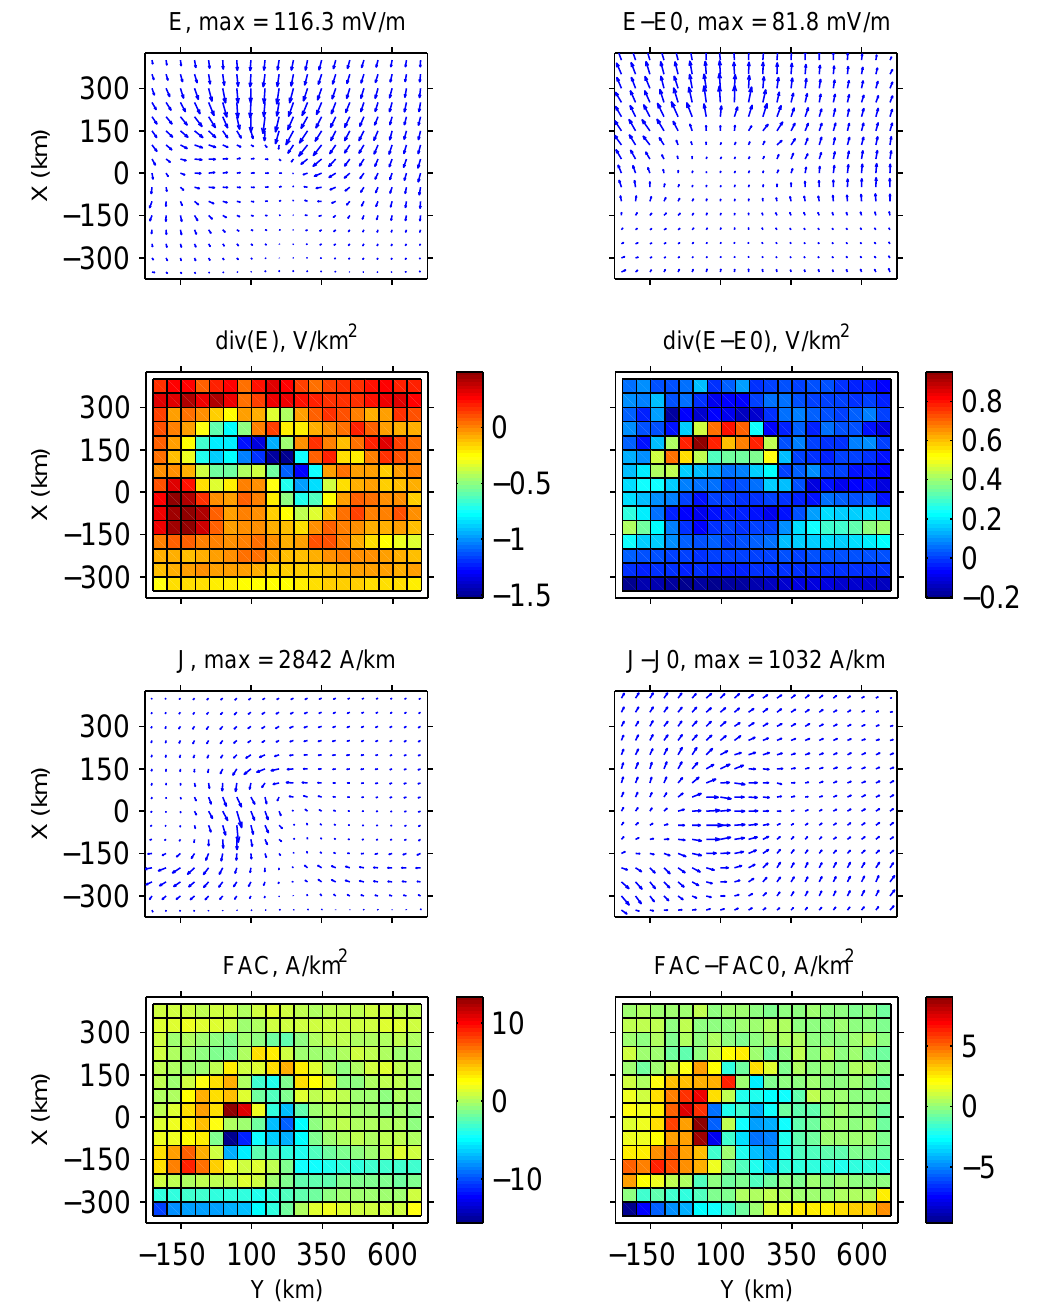
Fig. 7. Results of the CECS method for the (cid:127) -band model. Layout is similar to Fig. 3. Note the different scales of the vector plots.